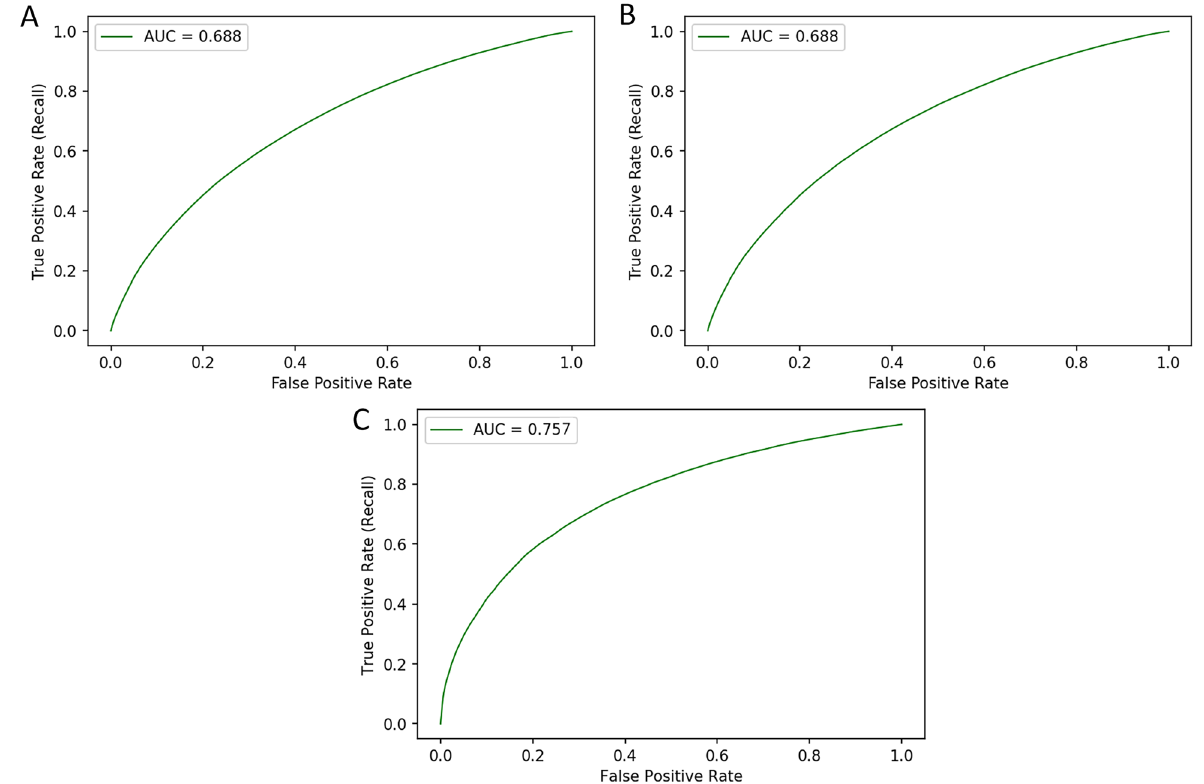
Figure 2. ROC Curve of ( A ) 50:50 balanced late visit classifier, ( B ) 60:40 unbalanced late visit classifier and ( C ) 50:50 balanced unsuppressed VL classifier. Unsuppressed VL Unsuppressed VL not observed observed Total observations Se/Sp metrics F1-score VL Balanced 50:50 model performance using test